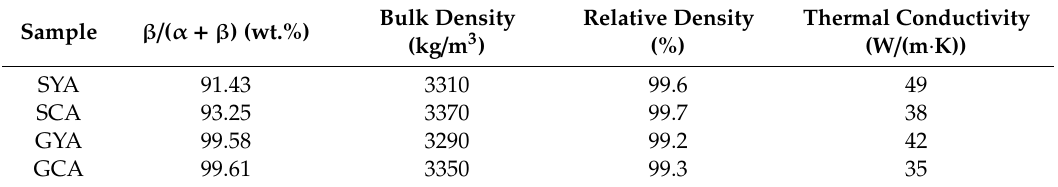
Table 2. The observed density, β -phase percentage, and thermal conductivity of samples.